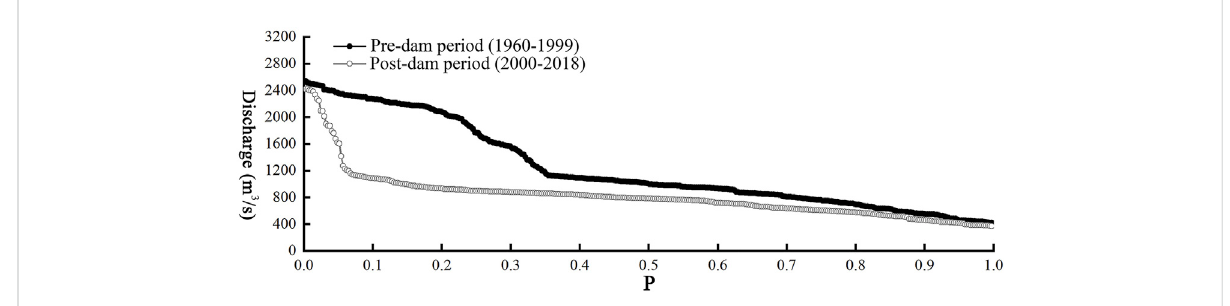
FIGURE 9 Empirical frequency curve of daily fl ow at Huayuankou Station on the Yellow River,